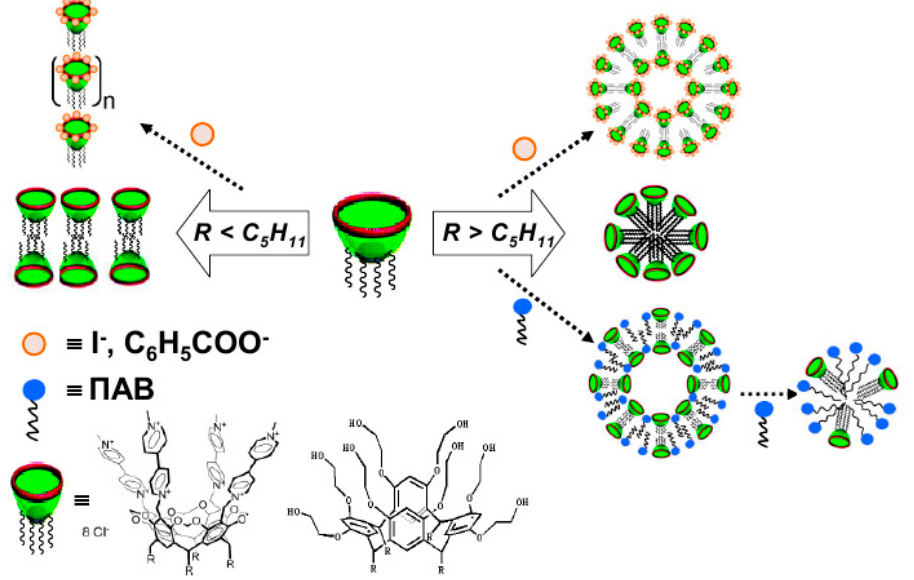
Figure 6. Changes in the morphology with the variation in the surfactants-calixresorcine ratio.